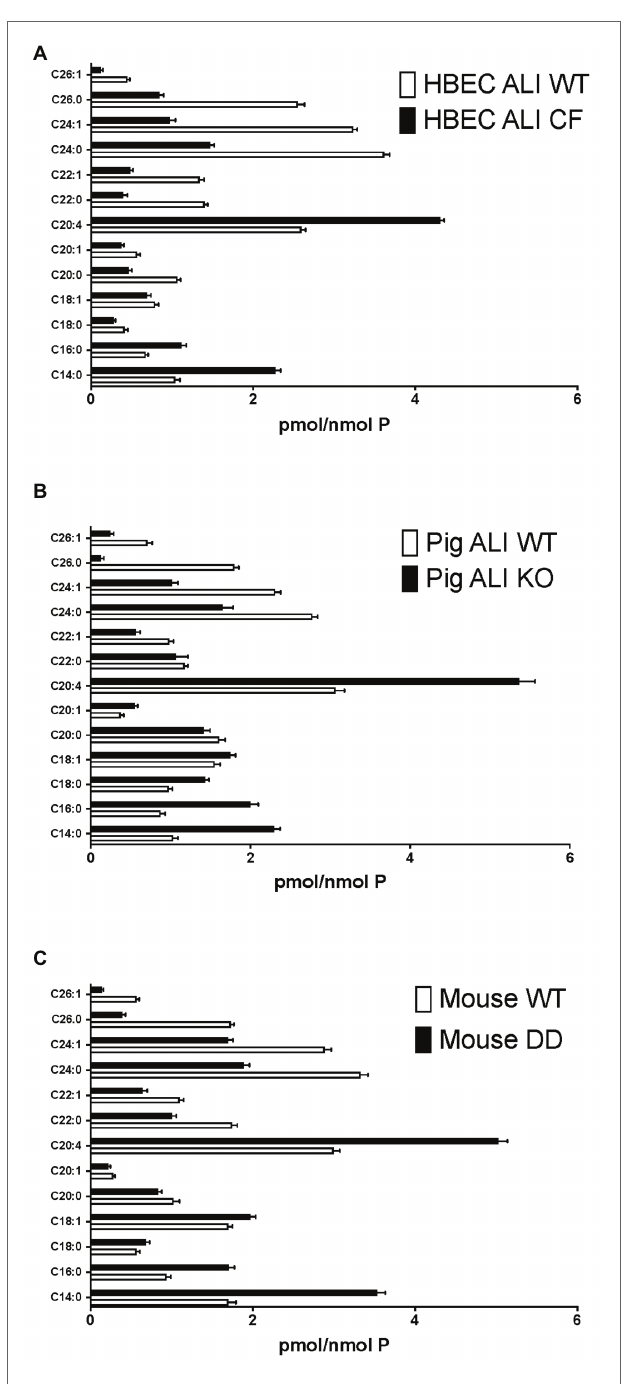
FIGURE 2 | Enhanced long-chain to very long-chain ceramide species ratio in CF airway cells and lung tissue. Lipids were extracted and analyzed by mass spectrometry, as described in methods merged and averaged data. The bars represent the average concentration of individual ceramide species expressed as pmol/nmol total lipid phosphate (pmol/nmol P , error bars: SEM). (A) Human bronchial epithelial cells in ALI culture (HBEC-ALI) CF (BCF000174; N = 12 inserts) compared to WT ( N = 12, three donors, four filters each), data merged from three independent experiments. Four other CF